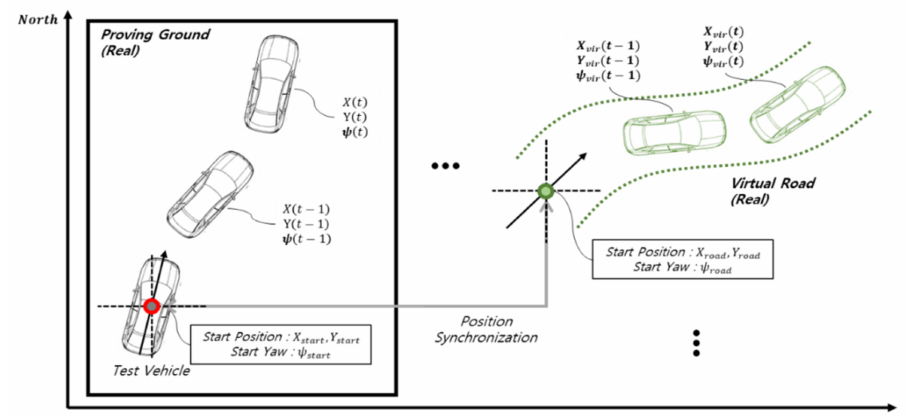
Figure 4. Concept of position synchronization between real and virtual